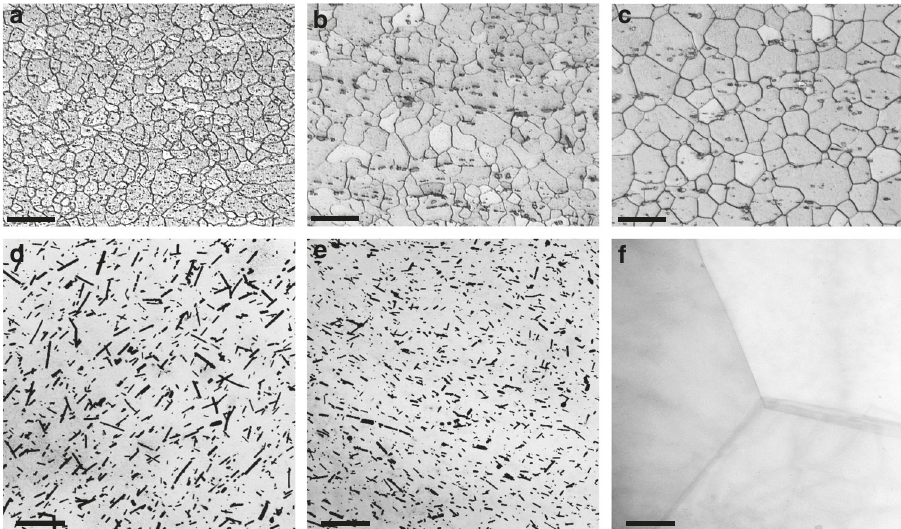
Fig. 2 Microstructure of the studied Mg alloys. a – c OM images of TRC-AZMX3110 ( a ), IC-AZMX3110 ( b ), and IC-AZX310 ( c ) showing grain size and distribution of coarse second phases particles. Scale bar of OM images corresponds to 20 μ m. d – f STEM images of TRC-AZMX3110 ( d ), IC-AZMX3110 ( e ), and IC-AZX310 ( f ) showing the presence of fi ne plate-shaped particles in TRC-AZMX3110 and IC-AZMX3110 and the absence of such fi ne particles in IC- AZX310. Scale bar of STEM images corresponds to 500